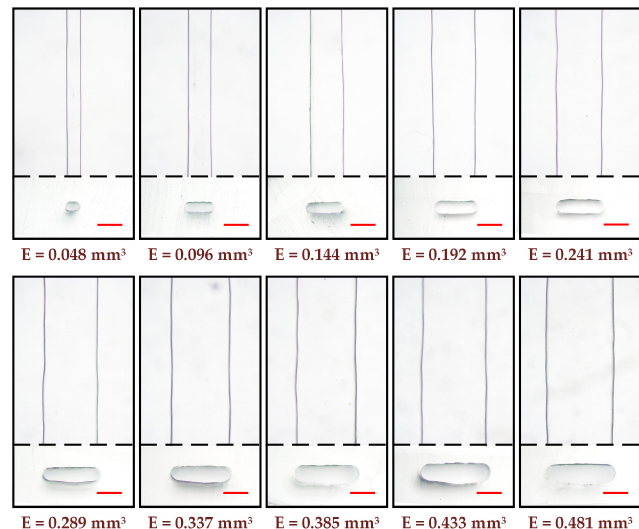
Figure 3. Optical micrographs of the low-aspect-ratio straight microchannels at di ff erent extrusion amounts. The top in each group is the vertical view of the microchannel, and the bottom in each group is the cross-sectional view of the microchannel. The red scale bar is 500 µ